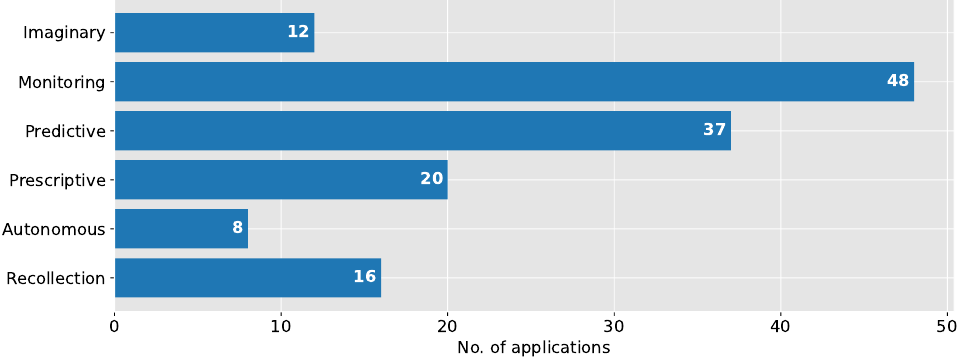
Figure 8. Results of the literature review—Absolute frequency of digital twin categories found in 38 publications. It should be noted that the total number of counts is not equal to the number of applications since they are not restricted to one